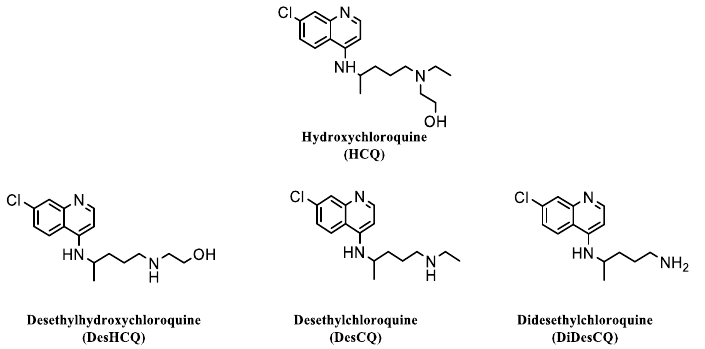
Figure 1. Chemical structures of hydroxychloroquine (HCQ) and its three